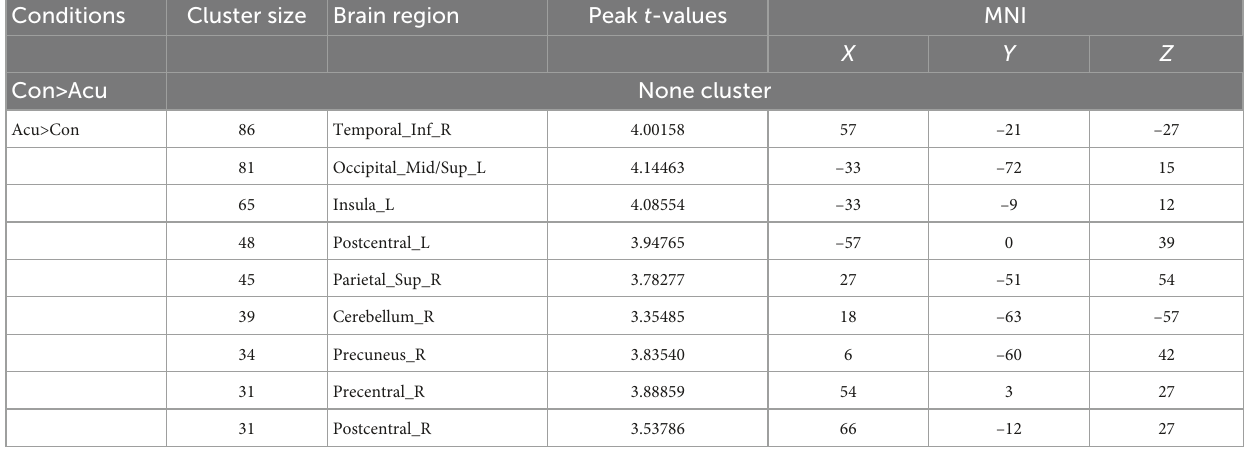
TABLE 4 Comparison of the difference between the before and after ALFF values of the two groups.